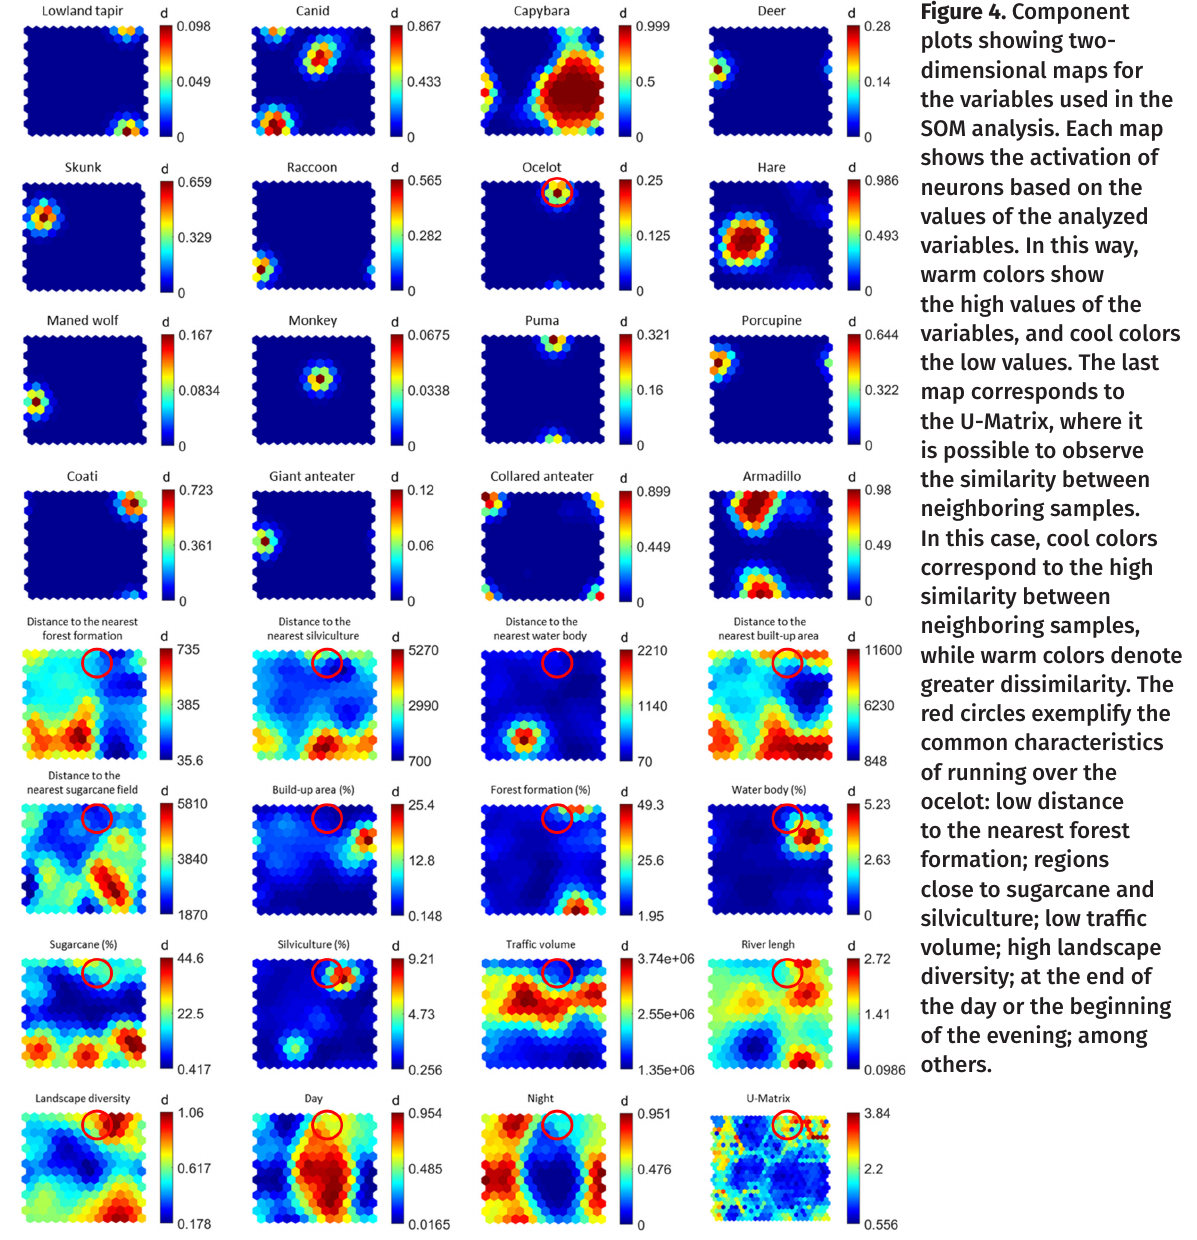
Figure 4. Component plots showing two- dimensional maps for the variables used in the SOM analysis. Each map shows the activation of neurons based on the values of the analyzed variables. In this way, warm colors show the high values of the variables, and cool